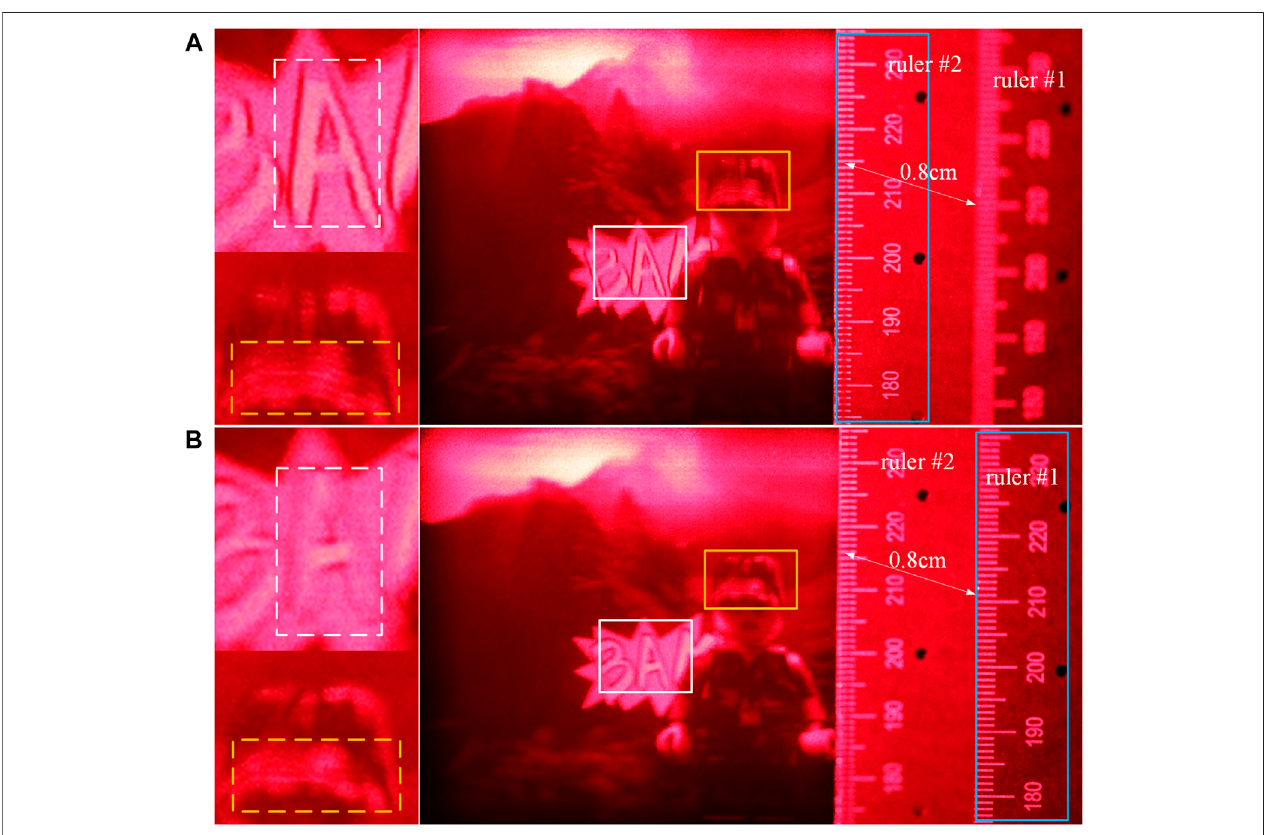
FIGURE 13 | Analysis of scene depth